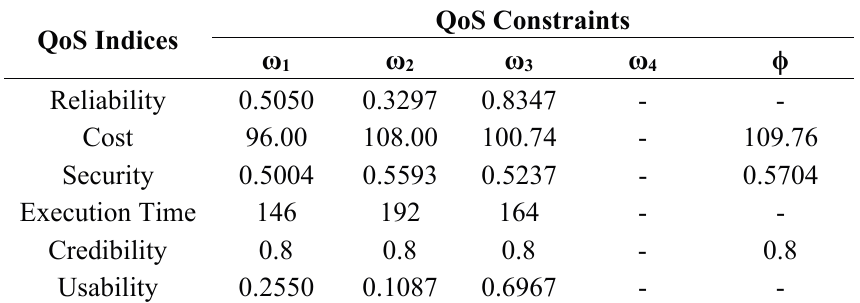
Table 2. The analytical values of QoS indices based on the VUGF of the entire